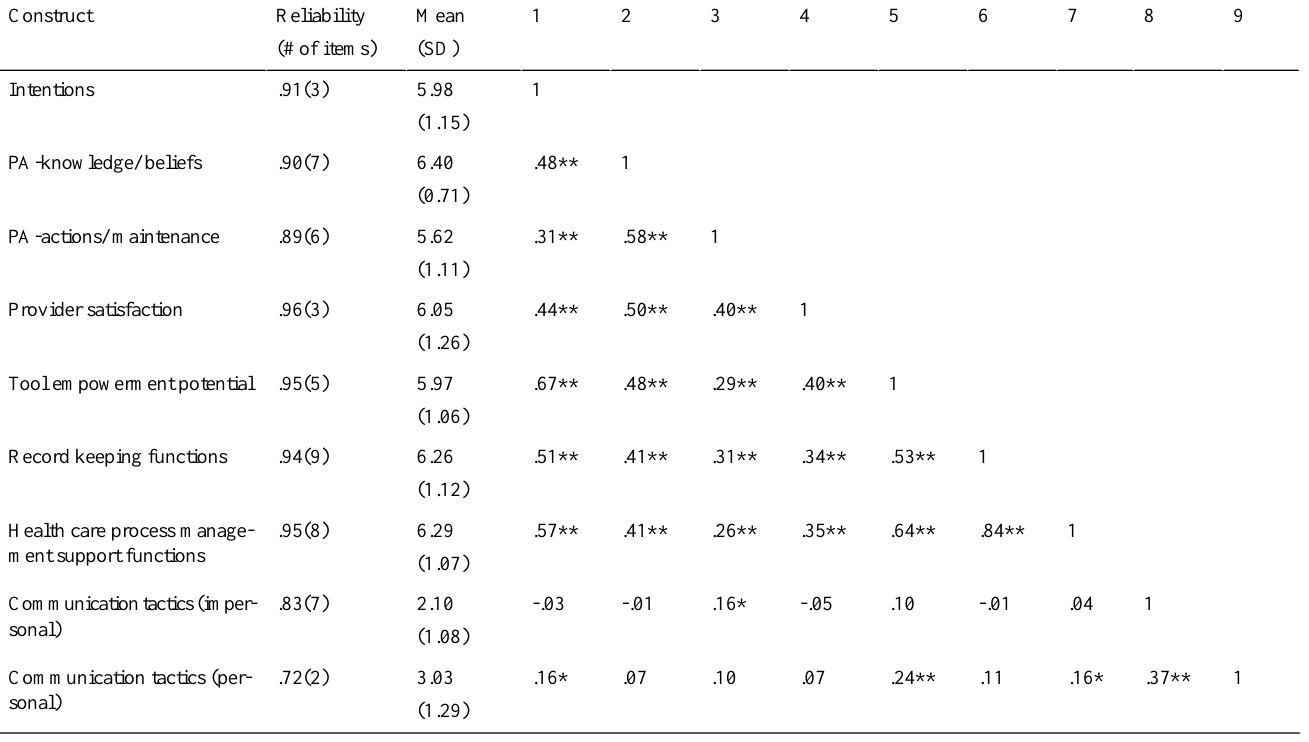
Table 2. Descriptive statistics: reliability, means, SDs, and correlations